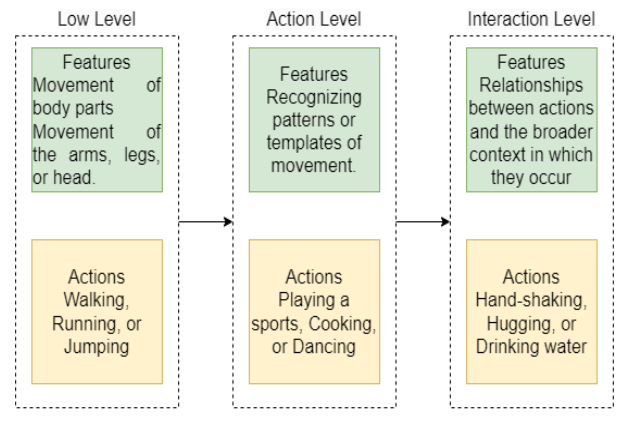
Figure 1. Intrinsic structure of human